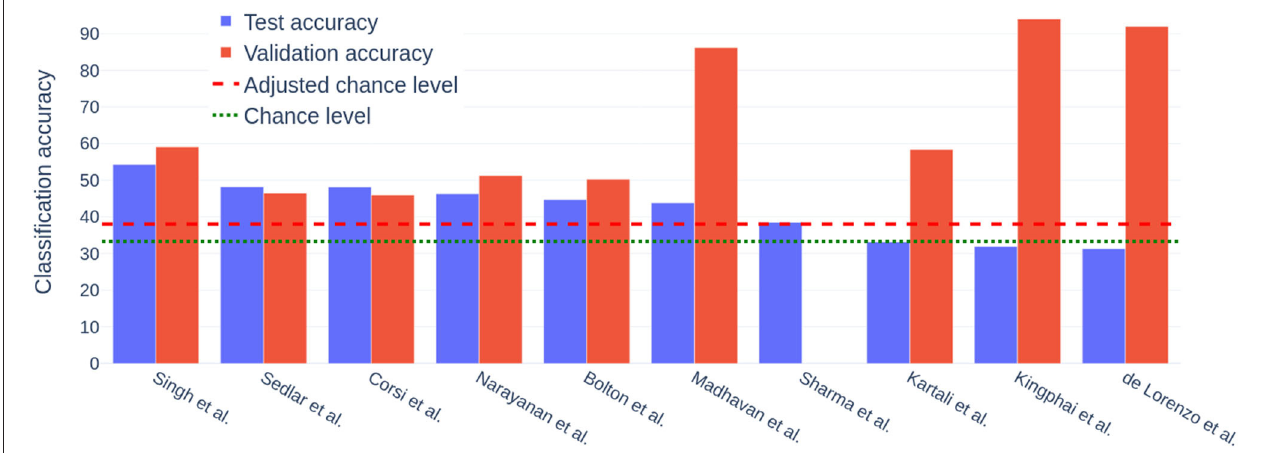
FIGURE 3 | Difference between the test accuracy (blue; from sessions 1 + 2 to 3), computed by the organizers, and the validation accuracy (orange; from sessions 1 to 2 or reverse), computed locally by competitors. A large discrepancy between the two indicates an issue with a generalization, i.e. ,